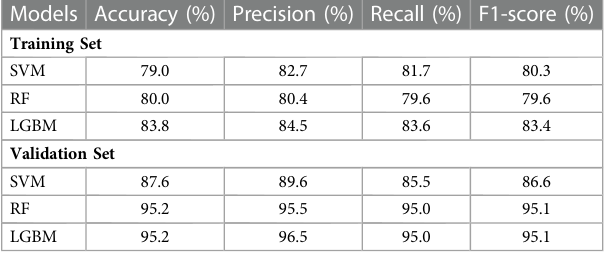
TABLE 4 Predictive performance of the three models in classifying IFC subtype in